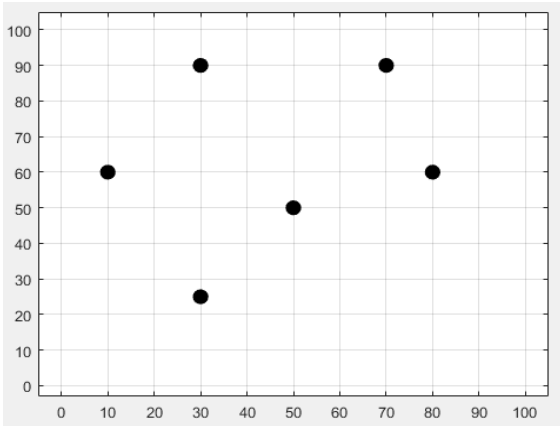
Figure 2. Plot of the location of the AN’s in the considered WSN-defined area. The input vector (